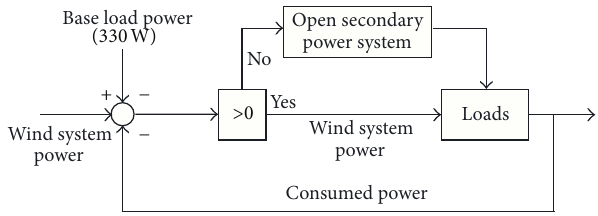
Figure 6: Basic block diagram of power management